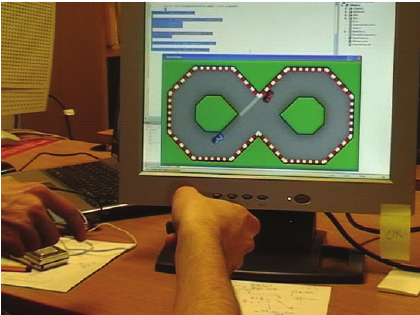
Figure 9: Users playing